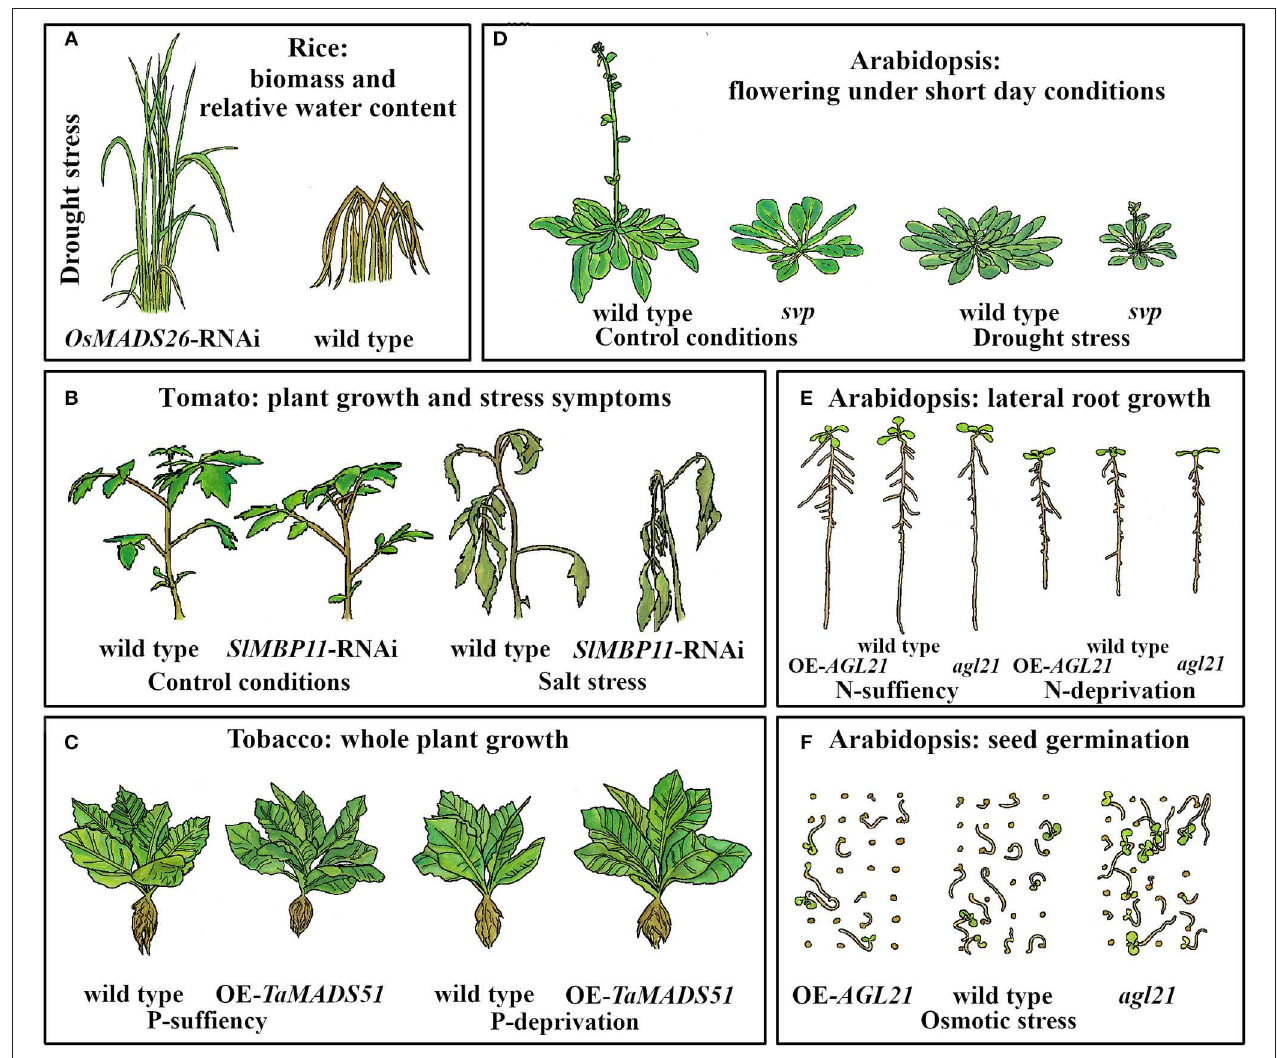
FIGURE 2 | MADS-box genes are involved in abiotic stress response in different developmental processes in several plants. (A) OsMADS26 is a negative regulator of drought stress tolerance in rice. The cartoon represents downregulation of OsMADS26 ( OsMADS26 -RNAi) and wild type plants in conditions of water stress for 18 days followed by 15 days of re-watering (Khong et al., 2015). (B) SlMBP11 is required in order to give more tolerance for salt stress to tomato plants. Plants are more affected by salt stress condition (100 mM NaCl) when this gene is downregulated ( SIMBP11 -RNAi) ( Guo et al., 2016). (C) Overexpression (OE) of TaMADS51 in transgenic tobacco plants improves plant growth under phosphorous (P)-deprivation (Shi et al., 2016). In Arabidopsis: (D) SVP repress the onset of the flowering in drought escape response at short day conditions. Cartoons are representative of wild type plants (16 weeks old) and svp mutants (8 weeks old) subjected to control conditions or drought regime (Riboni et al., 2013). (E) AGL21 is important for LR development in control conditions and under nitrogen (N)-deprivation (Yu L.-H. et al., 2014). (F) AGL21 function as a negative regulator of seed germination under osmotic stress conditions (300 mM mannitol) (Yu et al.,